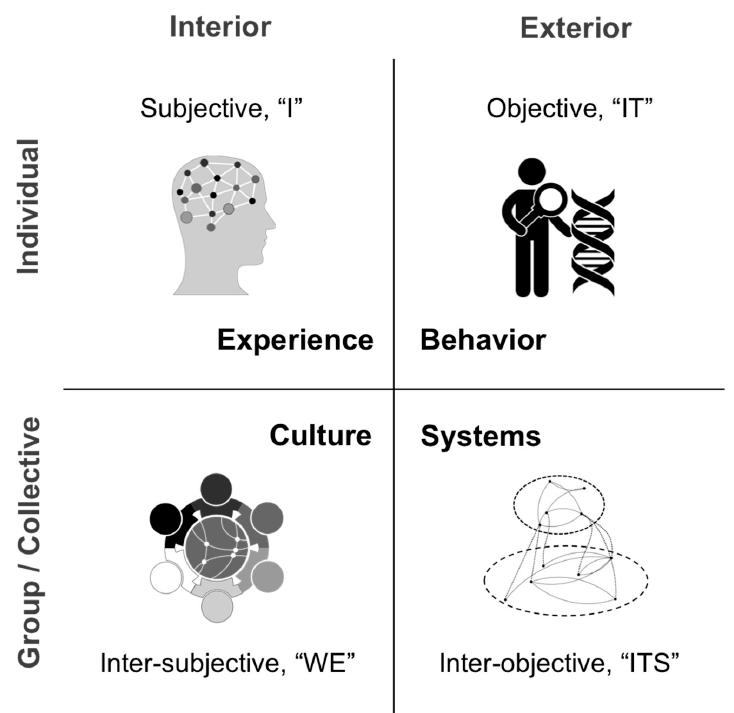
Figure 1. Integral Map of Human Perspectives. Adapted [34,60].